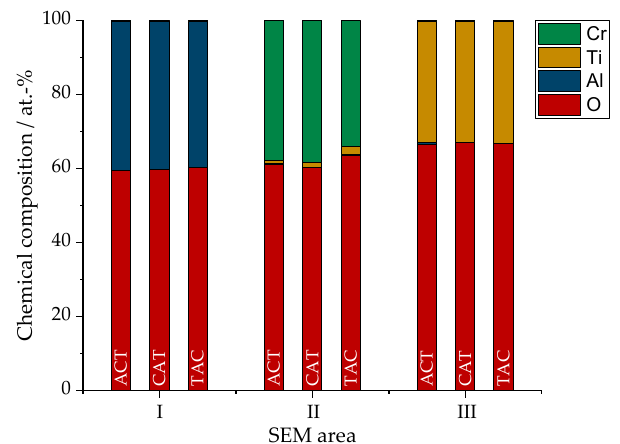
Figure 6. EDS analysis of composite coatings: chemical composition of the material areas marked in Figure 5b,d,f.